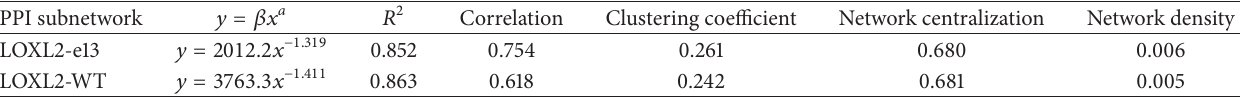
Figure 2: Power law fit of node-degree distribution for PPI subnetworks. The node degree (𝑘) is represented on the 𝑥 -axis and the number of nodes with 𝑘 is represented on the 𝑦 -axis. The graph displays a decreasing trend of degree distribution with an increase in the number of links, indicating scale-free topology. (a) Node-degree distribution of the LOXL2-e13-DEGs PPI subnetwork. (b) Node-degree distribution of LOXL2-WT-DEGs PPI subnetwork. Table 1: Network parameters of the LOXL2-e13-DEGs and LOXL2-WT-DEGs PPI